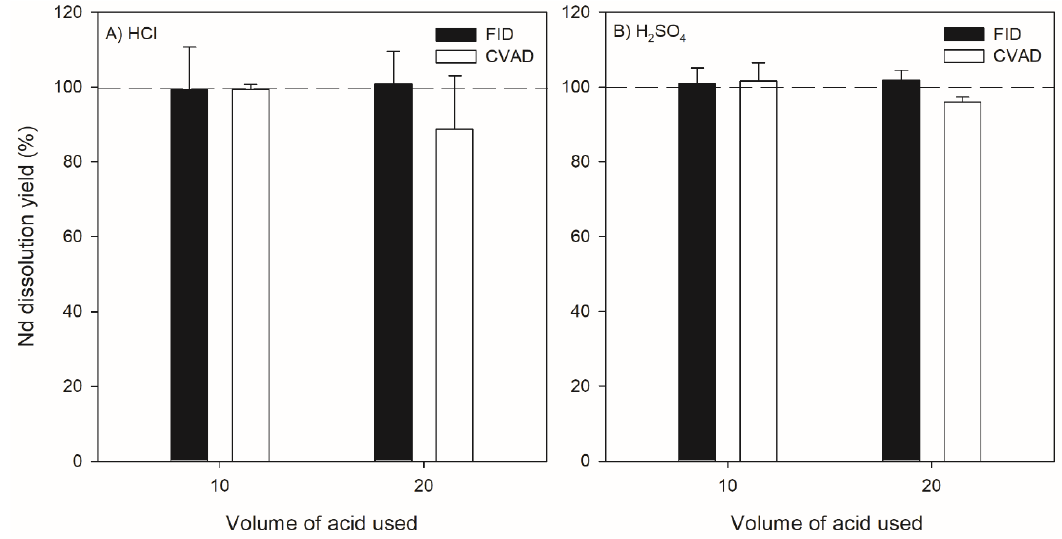
Figure 3. Comparison of FID and CVAD for the digestion of 1 g of magnet powder during 300 s with 10 mL of 3.2 N or 20 mL of 1.6 N of HCl or H 2 SO 4 .